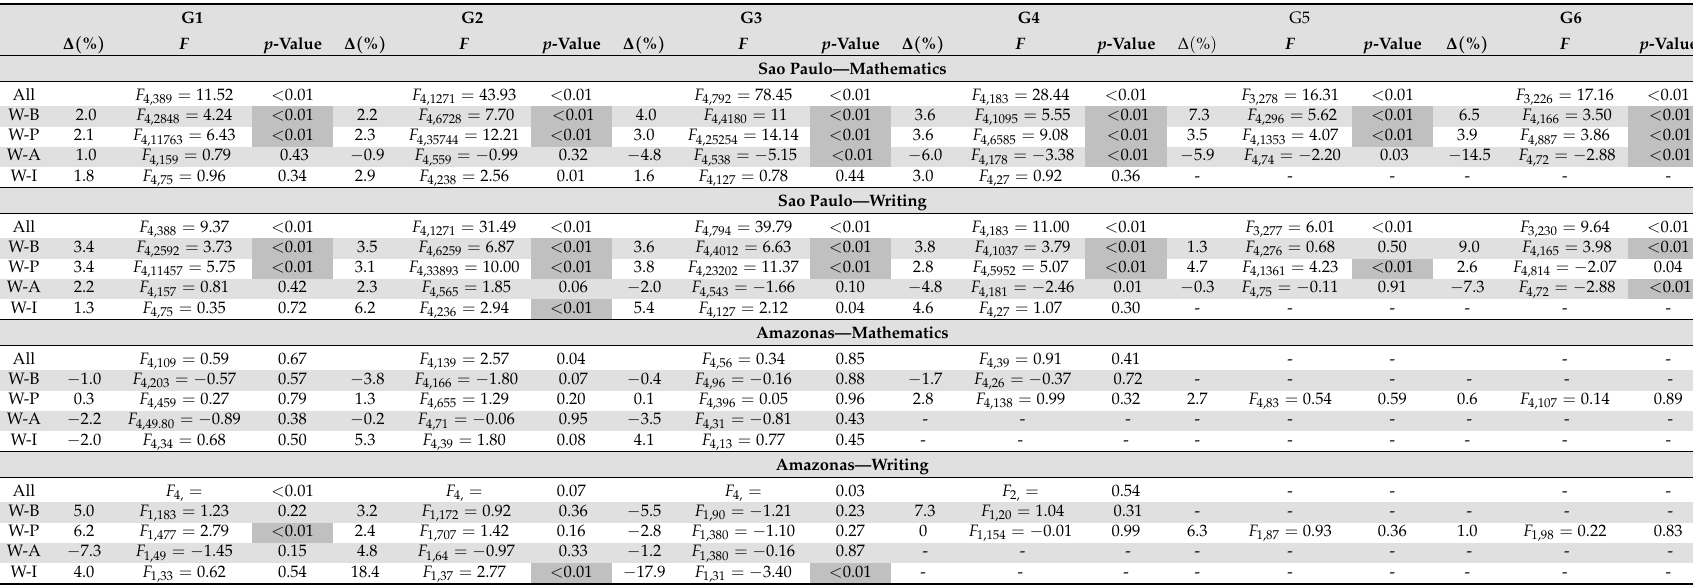
Table 1. Difference in the mean performance scores ( ∆ ) between ethnic categories and statistical significance of this difference ( p -value) for six household income levels (G1 to G6). The ethnic categories are White (W), Black (B), Pardo (P), Asian (A) and Indigenous (I). All means that all ethnic categories are compared together. Dark gray cells highlight cases where p < 0.01 and “-” indicates that no statistics were taken because of the sample size. G1 G2